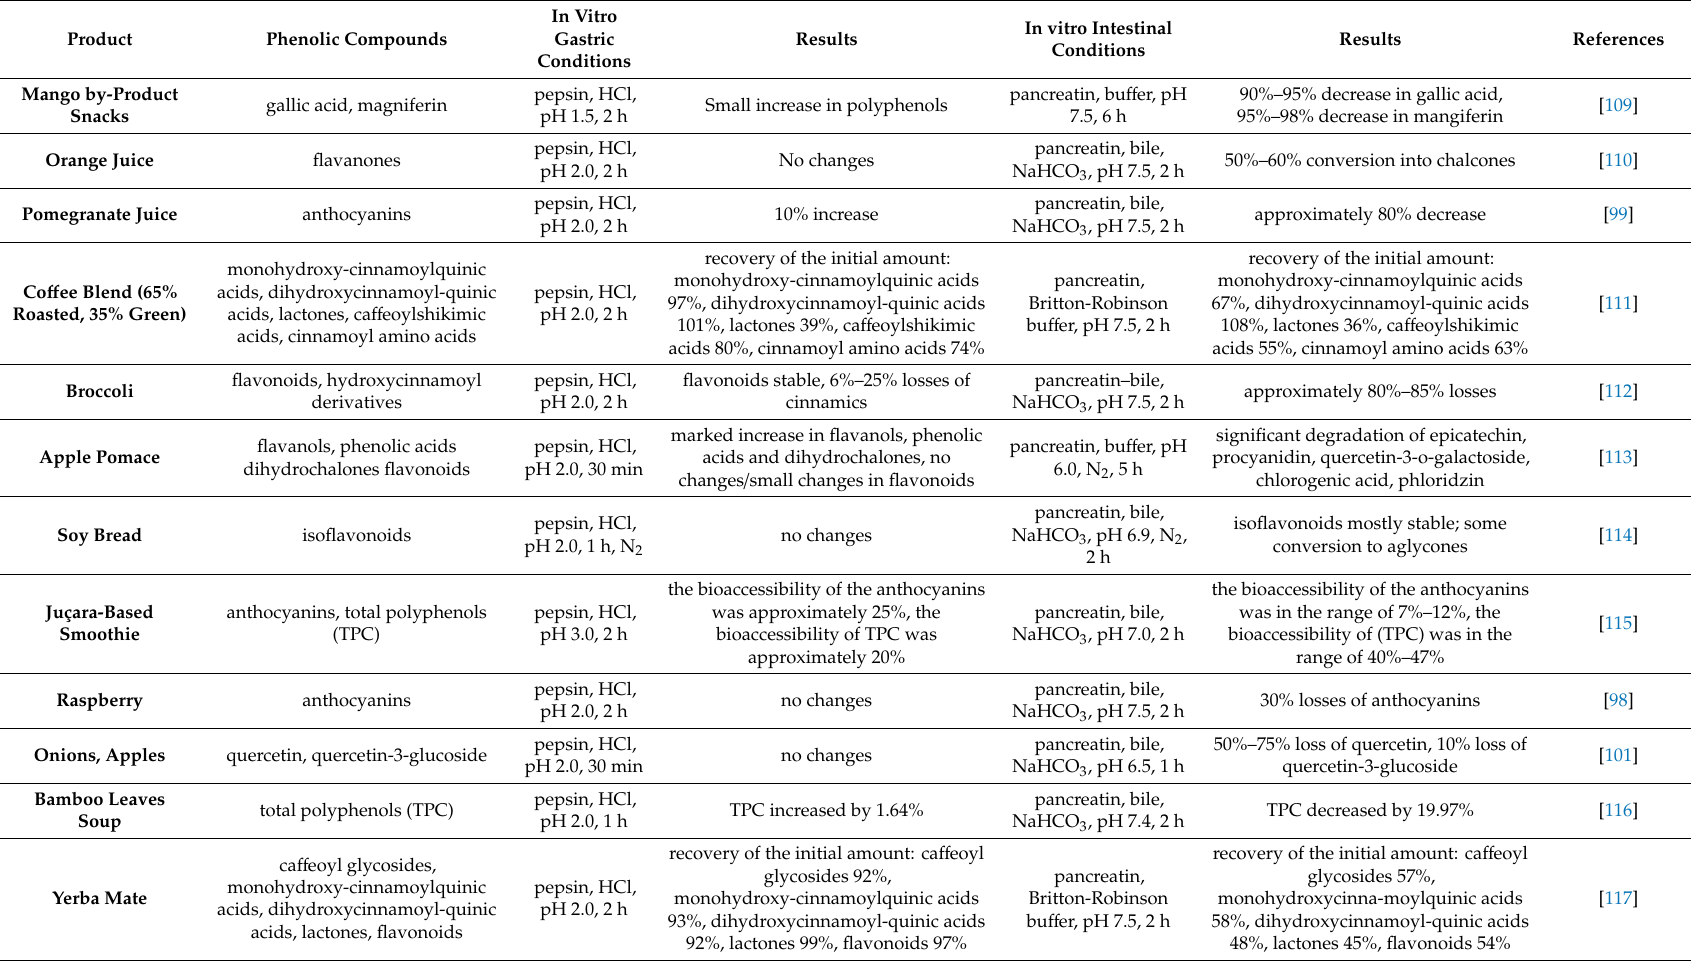
Table 2. In vitro gastric and intestinal simulated digestion of